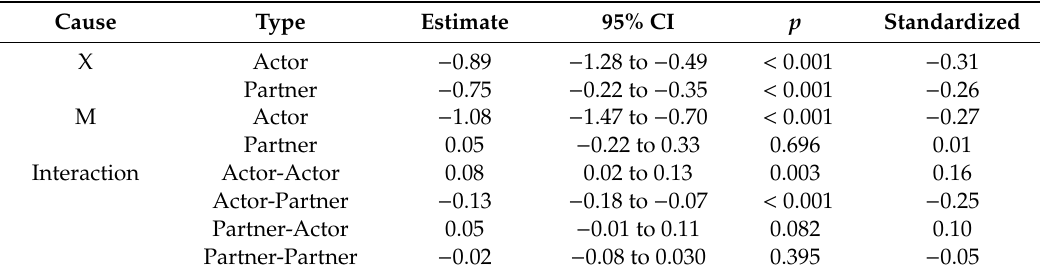
Table 4. Effects in the moderation model.